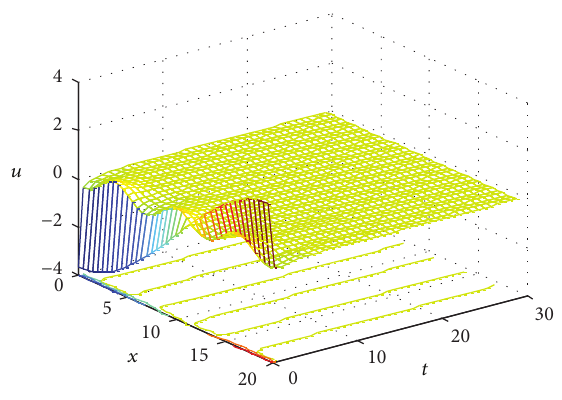
Figure 4: Profile of evolution of 𝑢(𝑥,𝑡) .